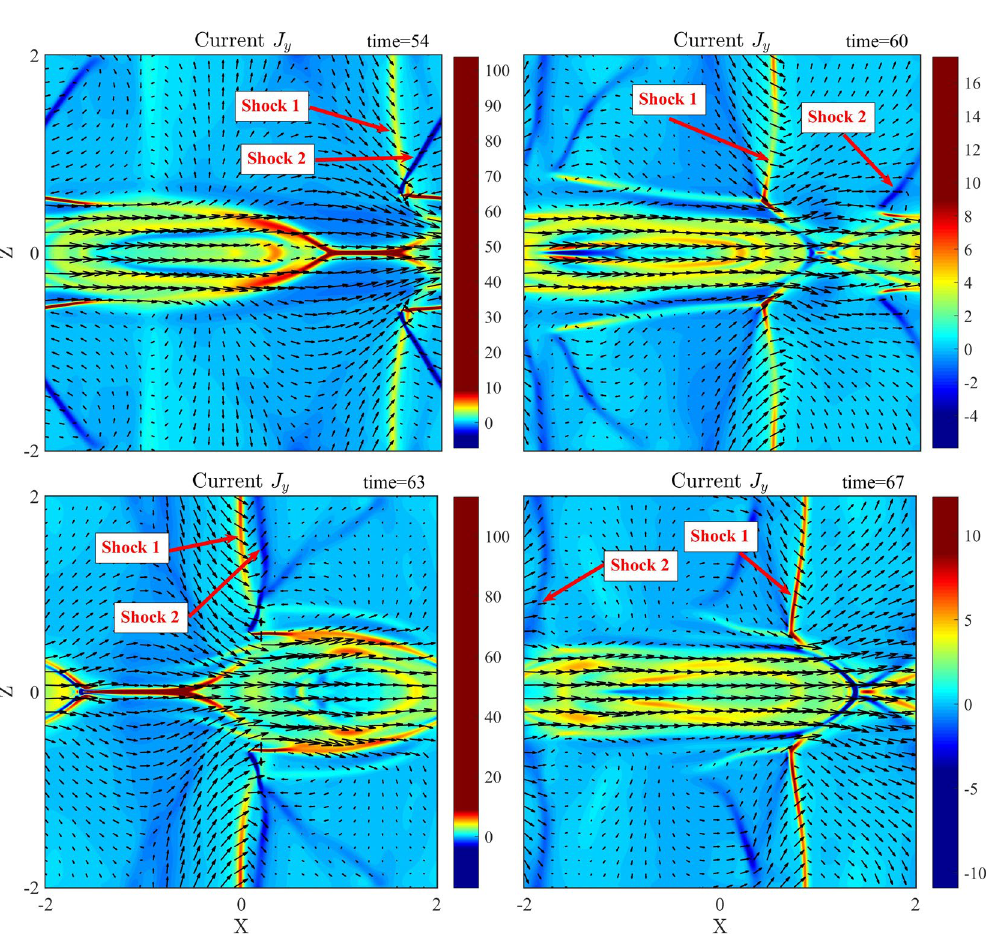
Figure 9. Color contours of the current density (J y ) with magnetic field lines (black solid lines) and flow vectors (black arrow) at t = 54, 60, 63, and 67, corresponding to d, e, f, and g labeled in Fig. 5,